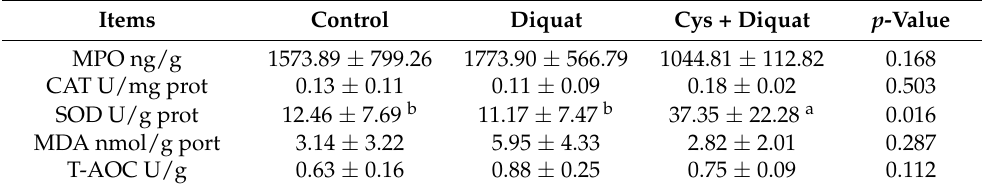
Table 7. Effect of dietary supplementation of coated cysteamine on the serum antioxidant indexes of pigs induced by